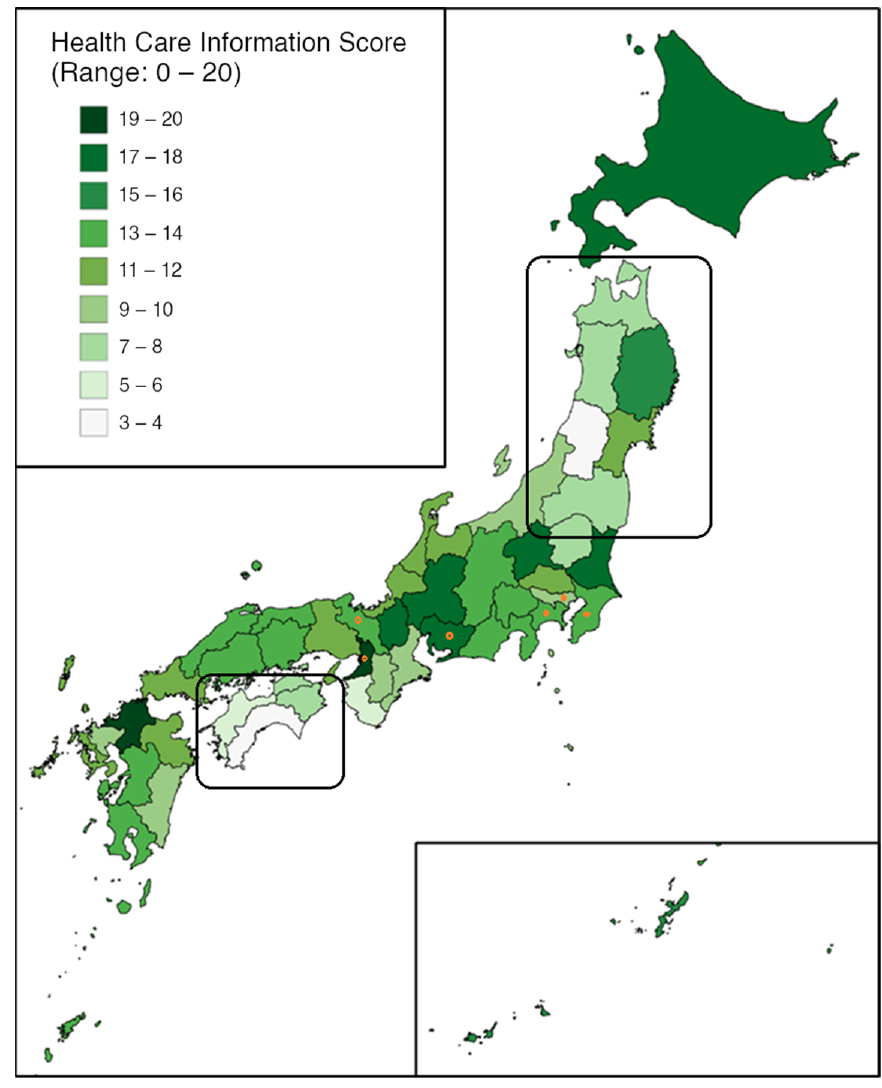
Figure 1. A geographic heatmap of multilingual health information environments by Japanese prefecture (roughly north-south orientation). Low scoring regions are outlined with rounded-edge boxes. Group 1 prefectures with a large foreign national population are marked with orange dots.